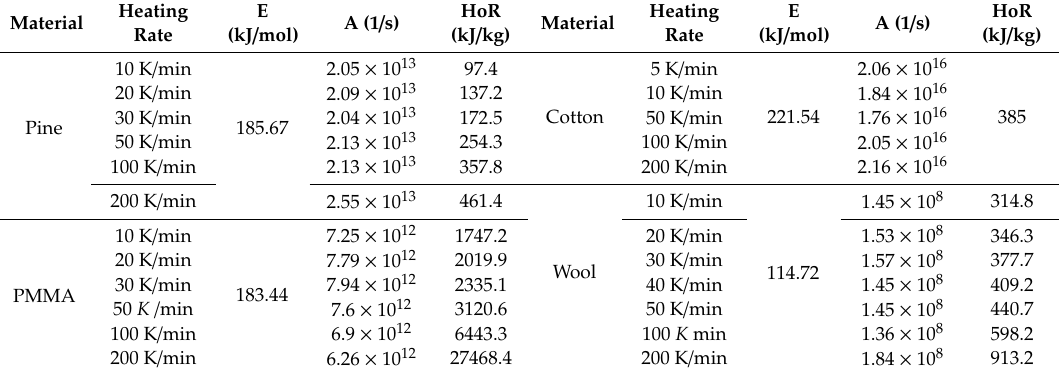
Table 2. Activation Energy (E) and Pre-exponential Factor (A) at Each Heating Rate and Heat of Reaction